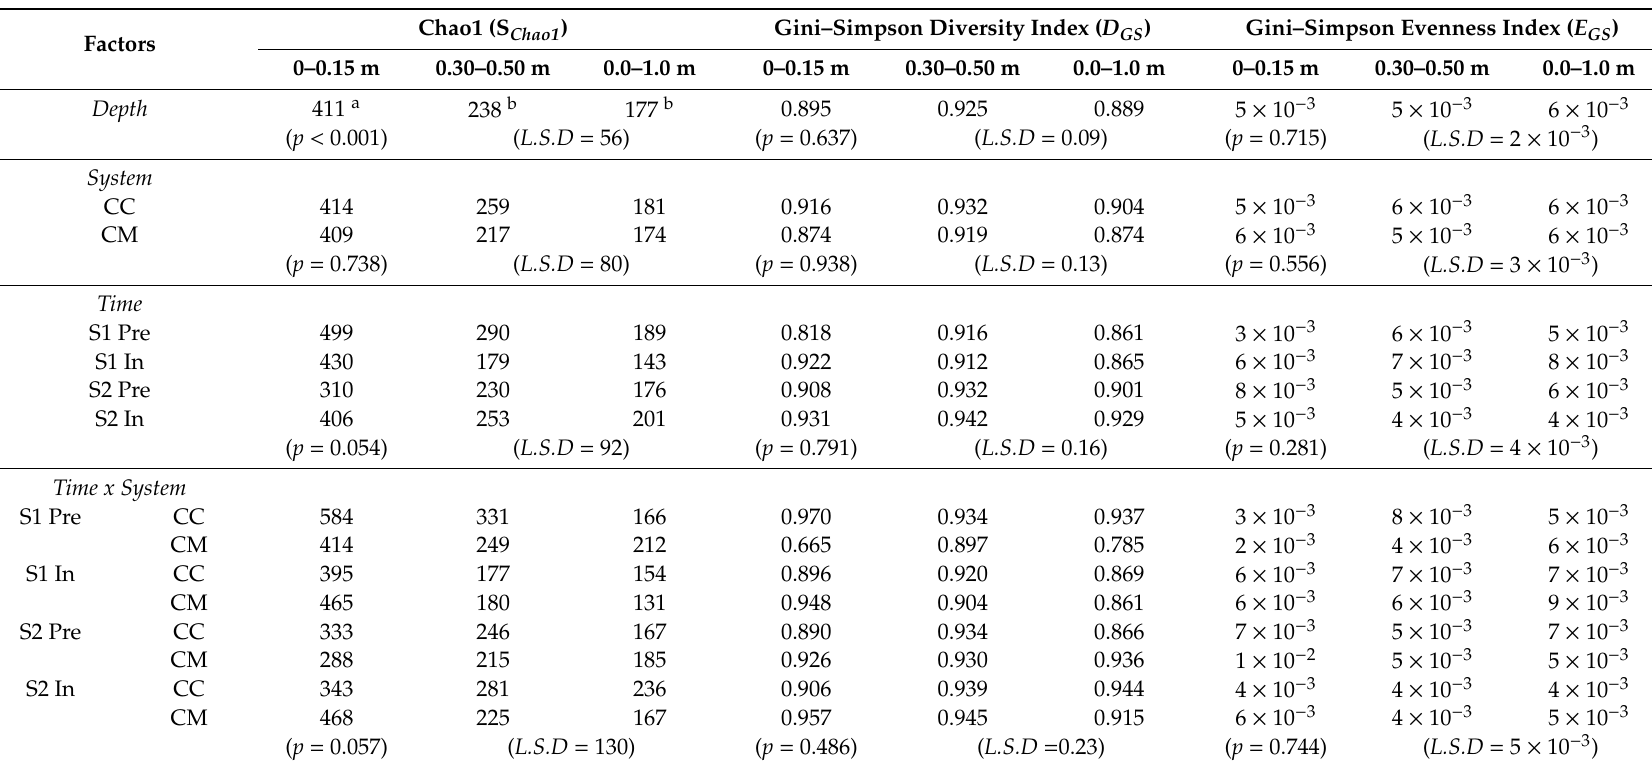
Table 3. Alpha-diversity of fungal ITS OTUs down the soil profile as measured by the Chao1 species richness indicator (S Chao1 ), the Gini–Simpson Diversity Index ( D GS ) and the Gini–Simpson Evenness Index ( E GS ) as influenced by system, sample time and sample time by depth. Lower case letters indicate significant di ff erences based on least significant values